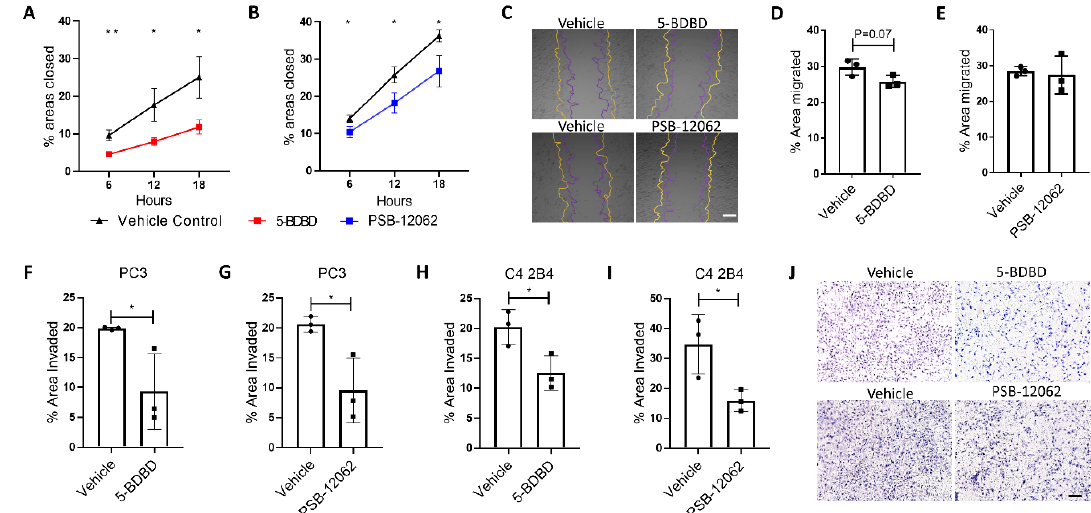
Figure 3. Inhibiting P2X4R with antagonists impairs PCa cell mobility. Changes in the migration and invasiveness of PC3 and C4-2B4 cells in response to the 1.0 μM 5-BDBD or 1.5 μM PSB-12062 treatment were examined using a scratch test and Transwell assays, respectively. For the scratch test migration assay, percentage areas closed after scratch were compared at 6, 12, and 18 h between ( A ) 5-BDBD- or ( B ) PSB-12062-treated and vehicle groups. ( C ) A representative image of the scratch test assay. Scale bar = 100 μm. For C4-2B4 cells, a Transwell migration assay was adopted with 10% FBS DMEM as the chemoattractant in the lower chamber. Percentage areas that migrated within 16 h were measured and compared between ( D ) 5-BDBD- or ( E ) PSB-12062-treated groups and the appropriate vehicle groups. ( F – I ) The invasion assay was performed by examining the ability of PC3 and C4-2B4 cells invading Matrigel-coated Transwell inserts over a 72-h period and comparing antagonist and vehicle groups. ( J ) A representative comparison image of the PC3 cells invading Matrigel-coated Transwell inserts, with or without P2X4R antagonist treatments. Scale bar = 200 μm. Data are the mean ± SD, n = three biological repeats, Student’s t-test, * p < 0.05, ** p < 0.01.